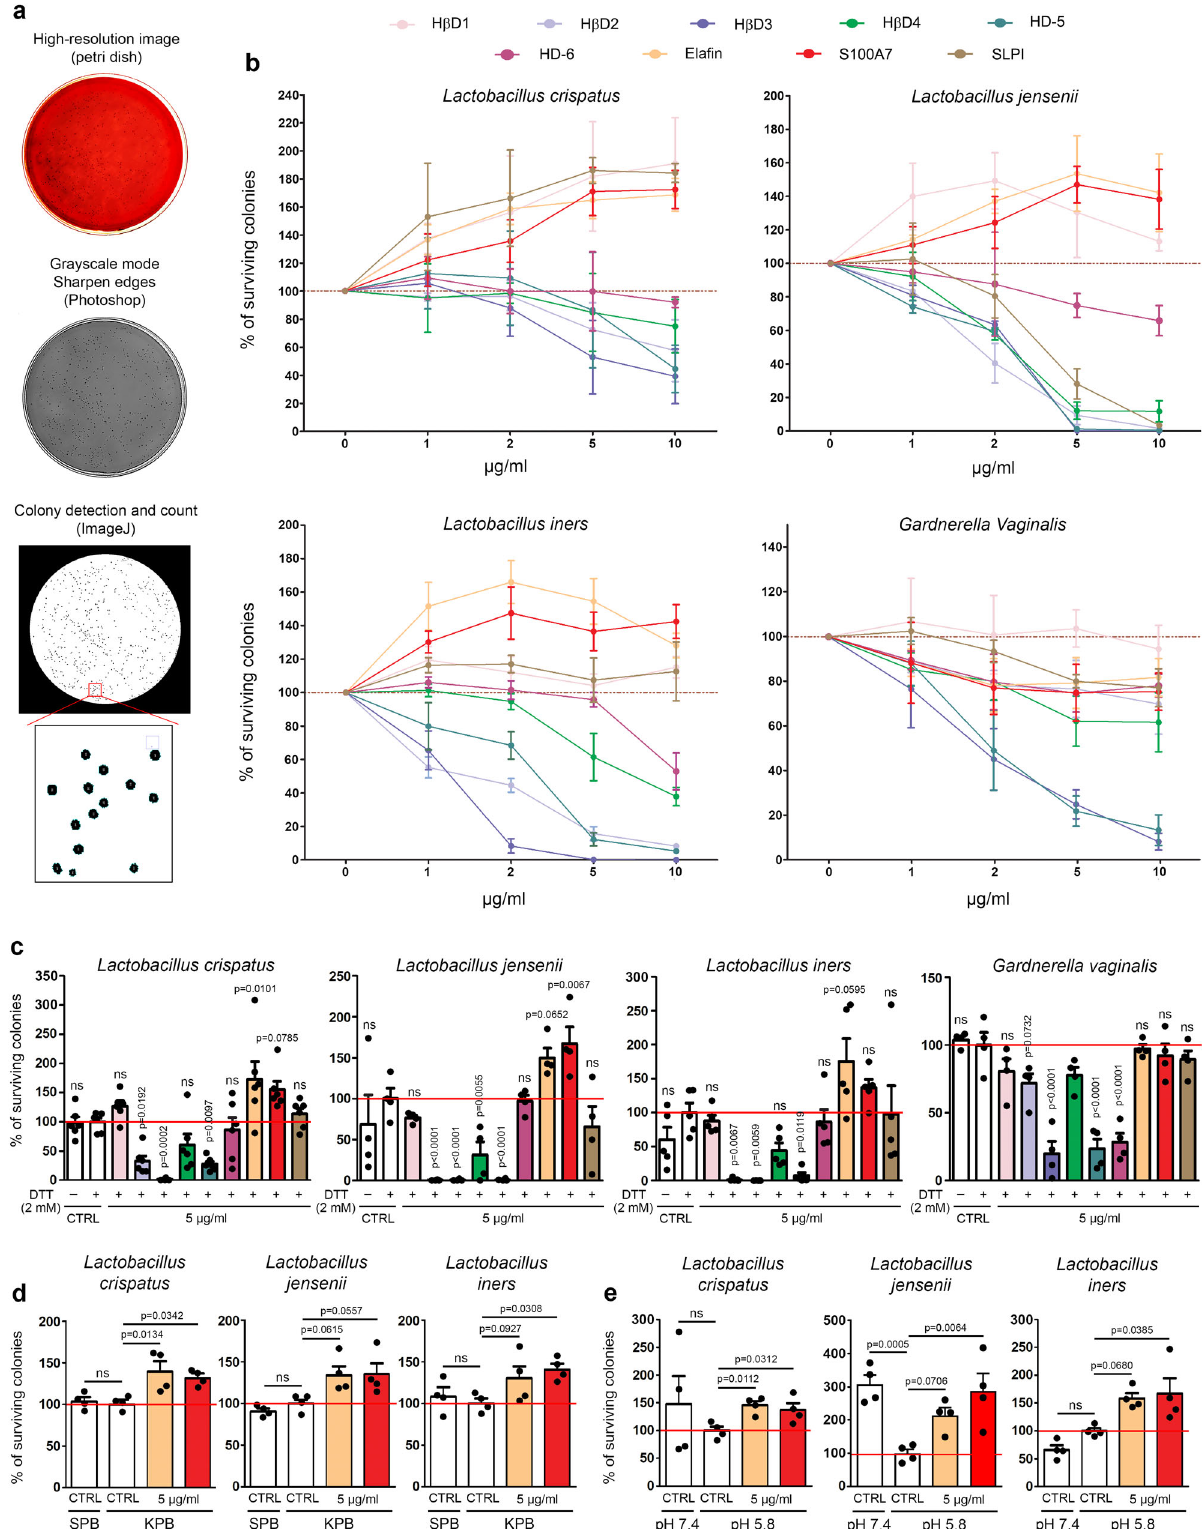
compared to the control group, as indicated by HOMOVA testing group clustering and clearly illustrated by the β -diversity plot (HSIL versus control, p = 0.09; hyperplasia/LSIL versus control, (Fig. 7e), the microbial pro fi les detected in HSIL-positive K14- p = 0.08). The distribution of the twelve main bacterial orders HPV16 mice were signi fi cantly distinct to those from hyperplasia/ and their relative abundance in the four groups of mice are shown LSIL-positive ( p = 0.002) or control mice ( p = 0.0005). In addi- in Fig. 7f. Accounting for over 90% of the total microbial com- tion, the homogeneity in the cervico-vaginal micro fl ora tended to munity in the vast majority of samples (44/48, 91.7%), the be different in mice diagnosed with a precancerous lesion NATURE COMMUNICATIONS| (2022) 13:1076